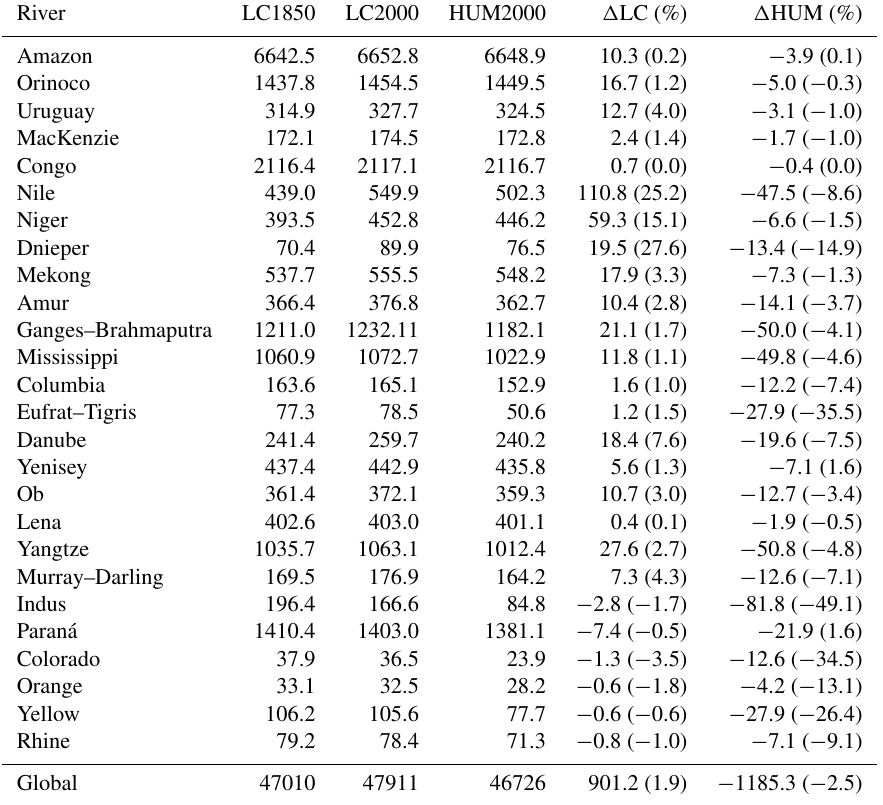
Table 3. Discharge to the ocean from 26 rivers (inkm 3 yr − 1 ) for LC1850, LC2000 and HUM2000 in the first three columns, and differences (percentage, given in brackets) in the last two columns. The symbol (cid:49) LC represents land cover change (LC2000 minus LC1850), and (cid:49) HUM represents human water use (HUM2000 minus LC2000). Of these 26 river basins, the impact of land cover change is larger than that of human water use in the first 9. In the last 6 basins, both land cover as well as human water use act to decrease discharge. Note that discharge of the Nile is much larger than observed (pre-Aswan), and PCR-GLOBWB does not perform well for the Nile so the absolute values need to be considered with